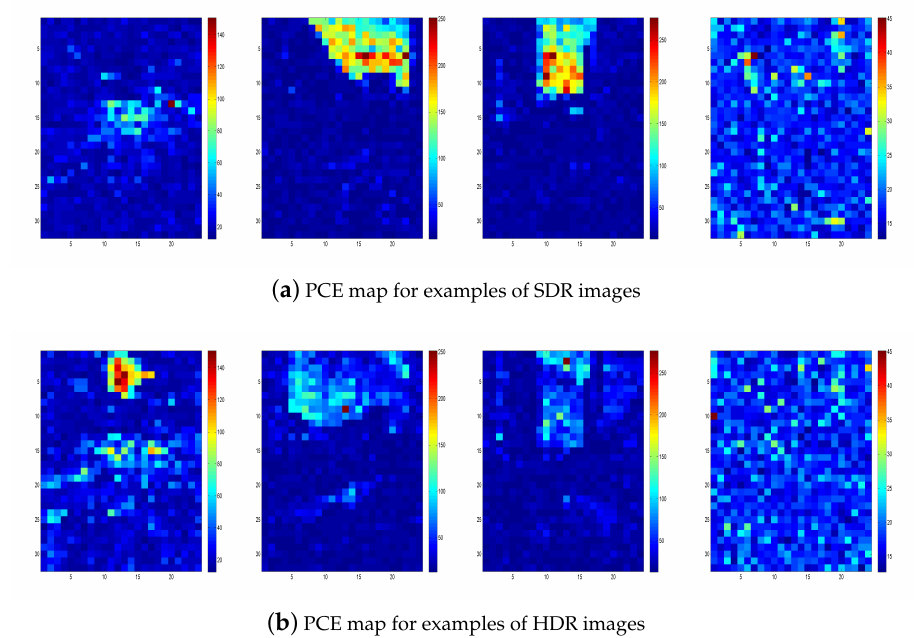
Figure 11. PCE maps for examples of SDR and HDR